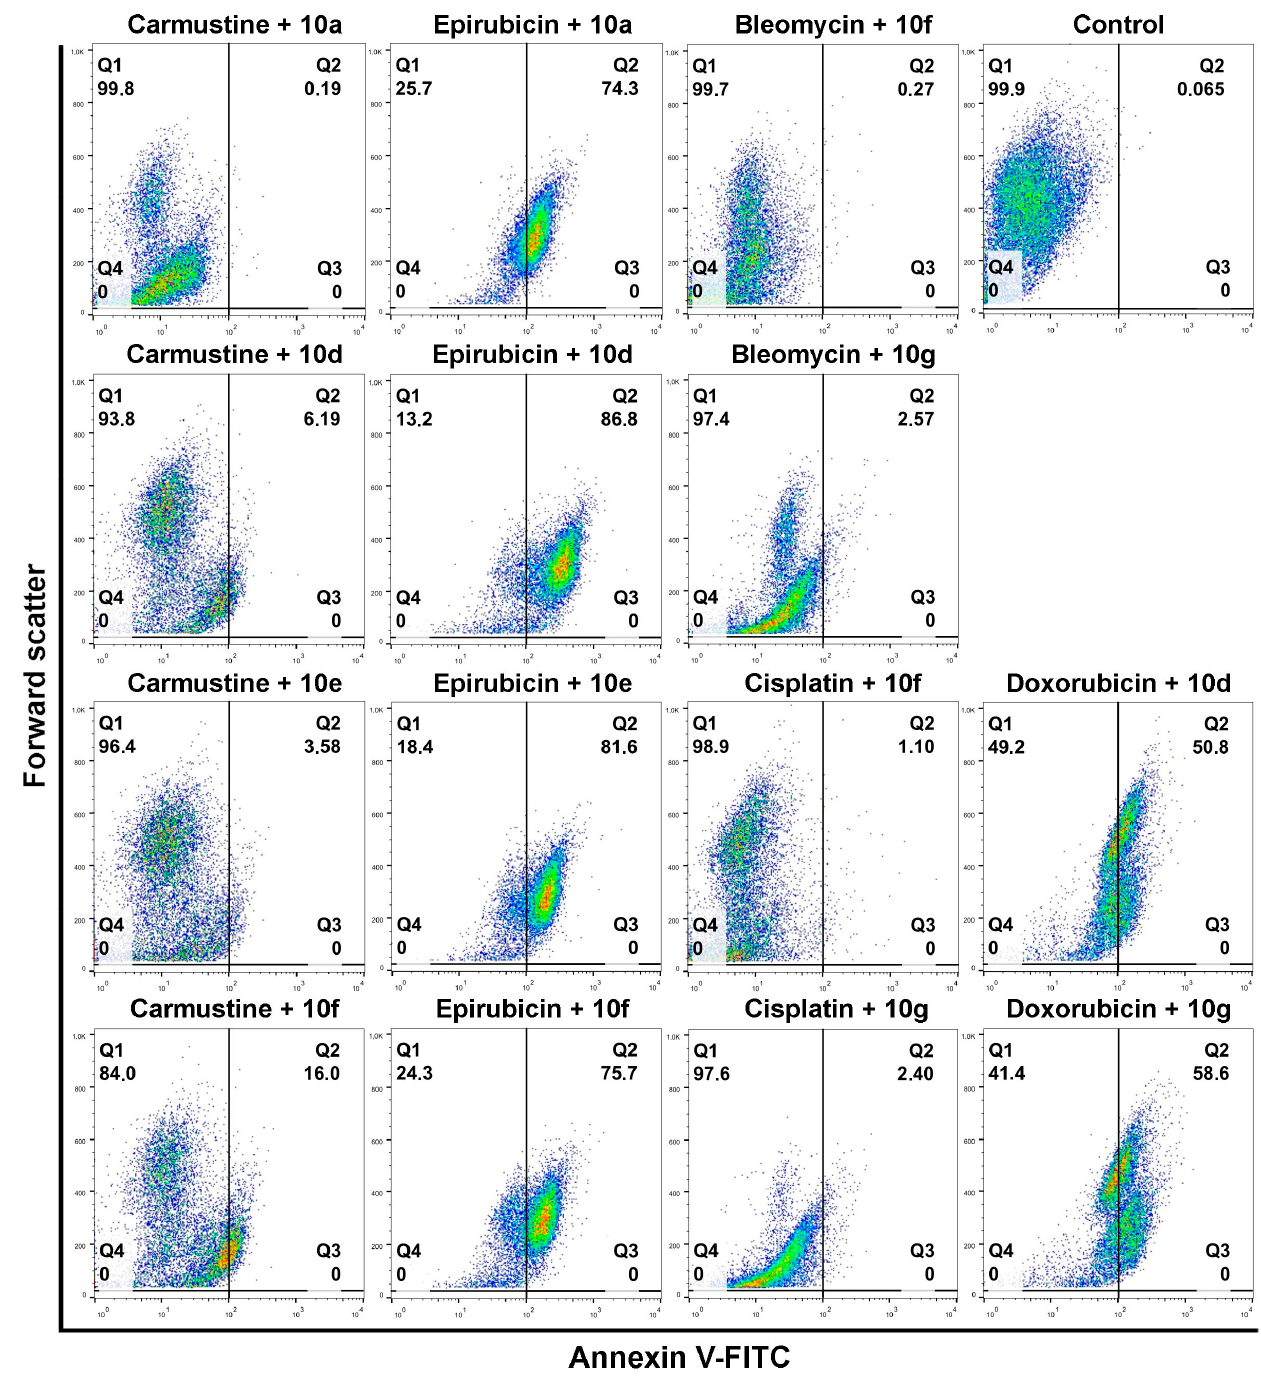
Figure 5. Androstano-arylpyrimidine 17-acetates sensitize Colo 320 cells to chemotherapy drug-induced apoptosis. Annexin V-fluorescein isothiocyanate fluorescence of 10,000 cells/sample were measured with flow cytometry and plotted against forward scatter. Cells were treated either with selected combinations prepared from compound 10a, 10d, 10e, 10f, or 10g (in 20 μ M concentration for 24 h) and chemotherapy drugs (Bleomycin, Carmustine, Cisplatin, Doxorubicin, or Epirubicin at various concentrations, please refer to Materials and methods and Supplementary Material Table S2) for 24 h. The numbers in the Q2 quadrants represent the percentage of Annexin V-positive apoptotic cells. In the color density plots each dot represents a single detected event.